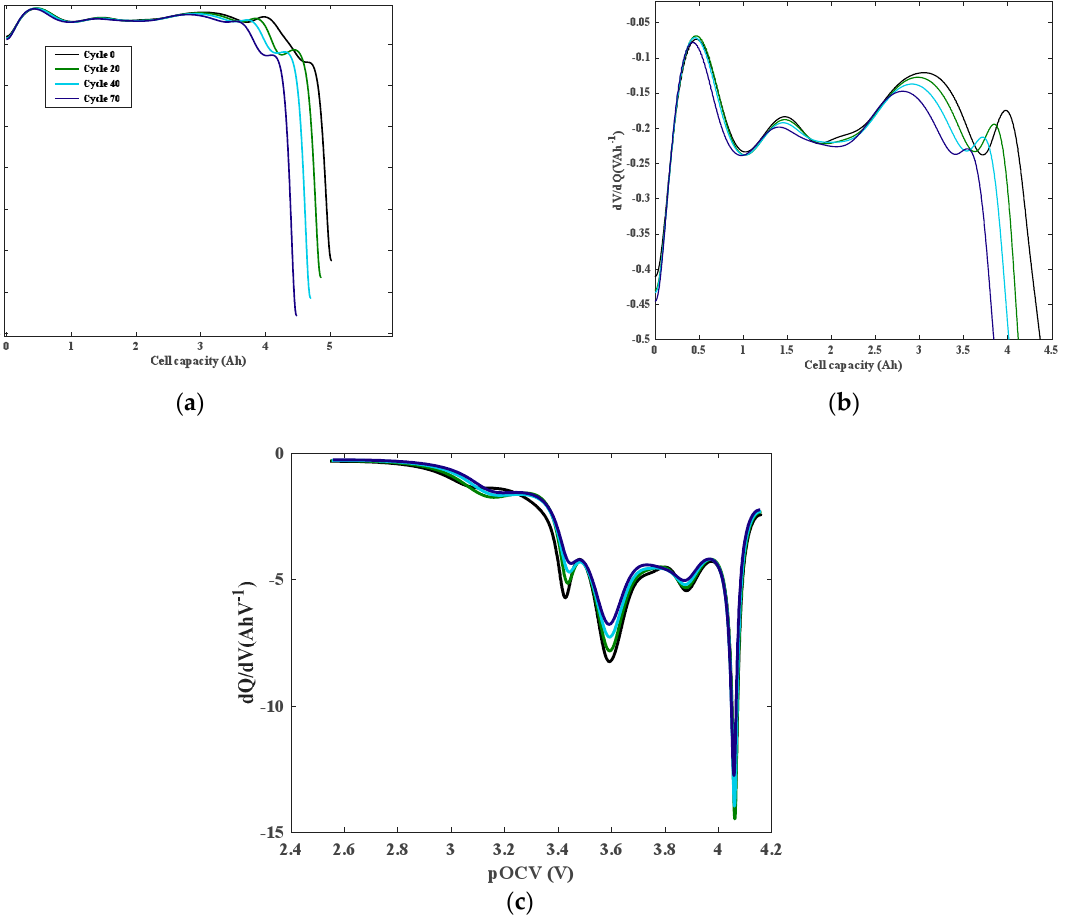
Figure 1. IC-DV curve of Cell L ( a ) DV curve. ( b ) magnified view of the DV curve. ( c ) IC curve.